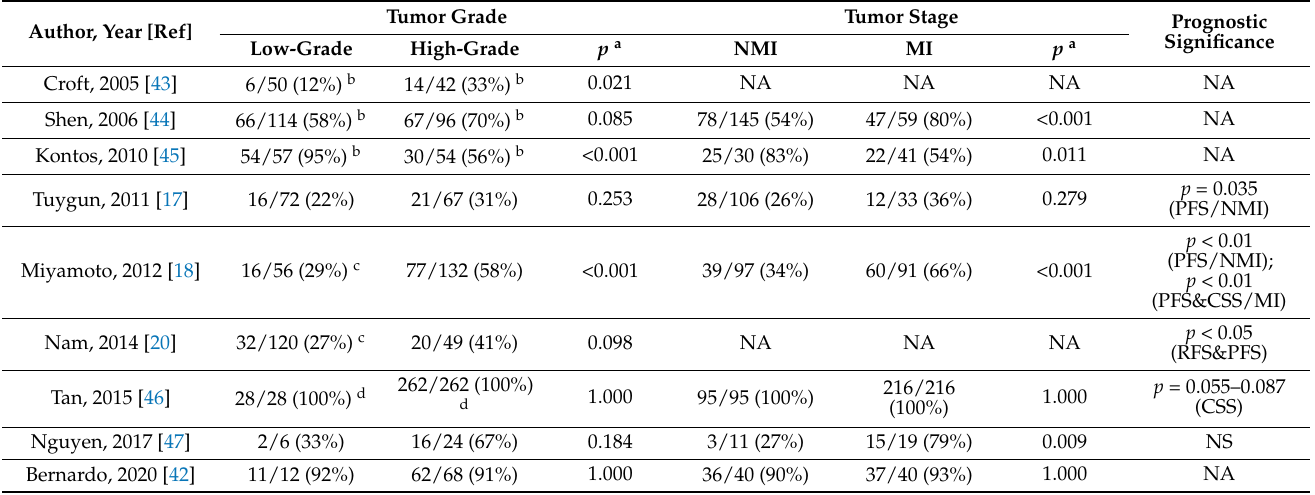
Table 3. Immunoreactivity for ER β in low-grade vs. high-grade and NMI vs. MI bladder cancers and its prognostic